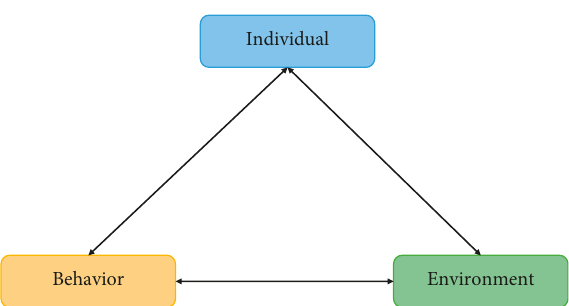
Figure 5: A theoretical model of entrepreneurial